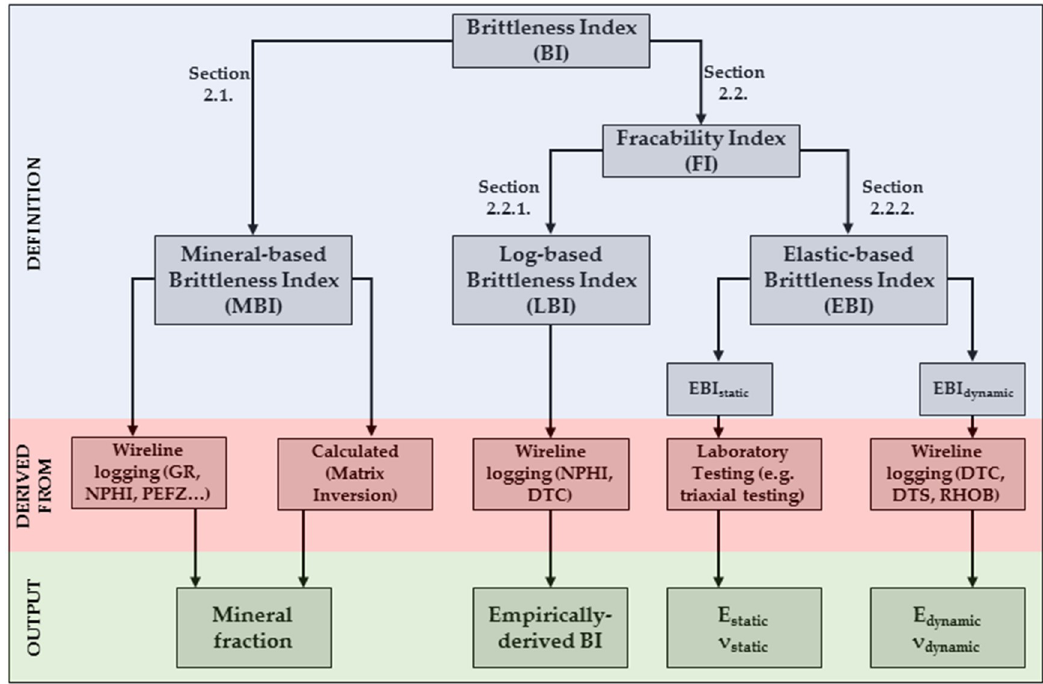
Figure 1. Workflow to derive the Brittleness Index.